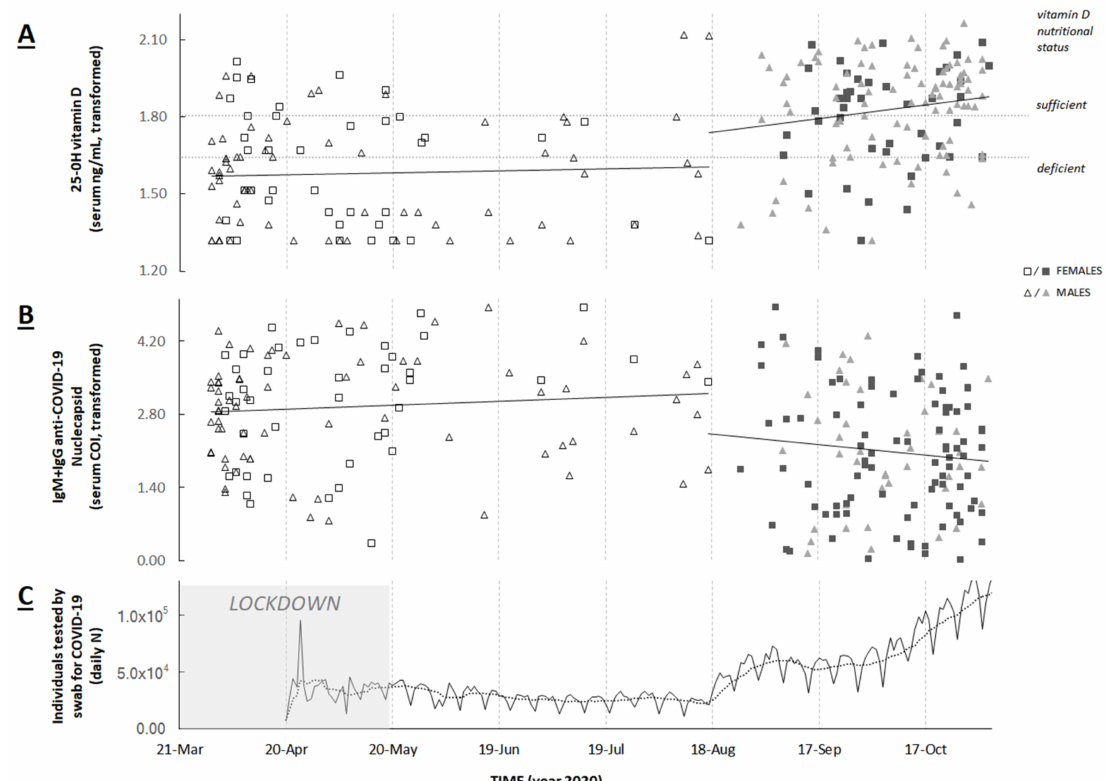
Figure 1. Summary of serum 25-OH vitamin D ( A ), IgM+IgG anti-COVID-19 nucleocapsid protein ( B ) and number of individuals tested per day by swab for COVID-19 ( C ); (panels A , B ): solid lines represent the trend and level of the segment regression (statistical analysis is detailed in Table 1); the dotted horizontal lines in panel B represent the transformed reference values of vitamin D status corresponding to sufficient (=20 ng/mL) and deficient (=12 ng/mL) condition; (panel C ): the gray shaded area represents the period of lockdown; the grey dotted line is the 7-day mobile average overlapped with the daily number of tested subjects